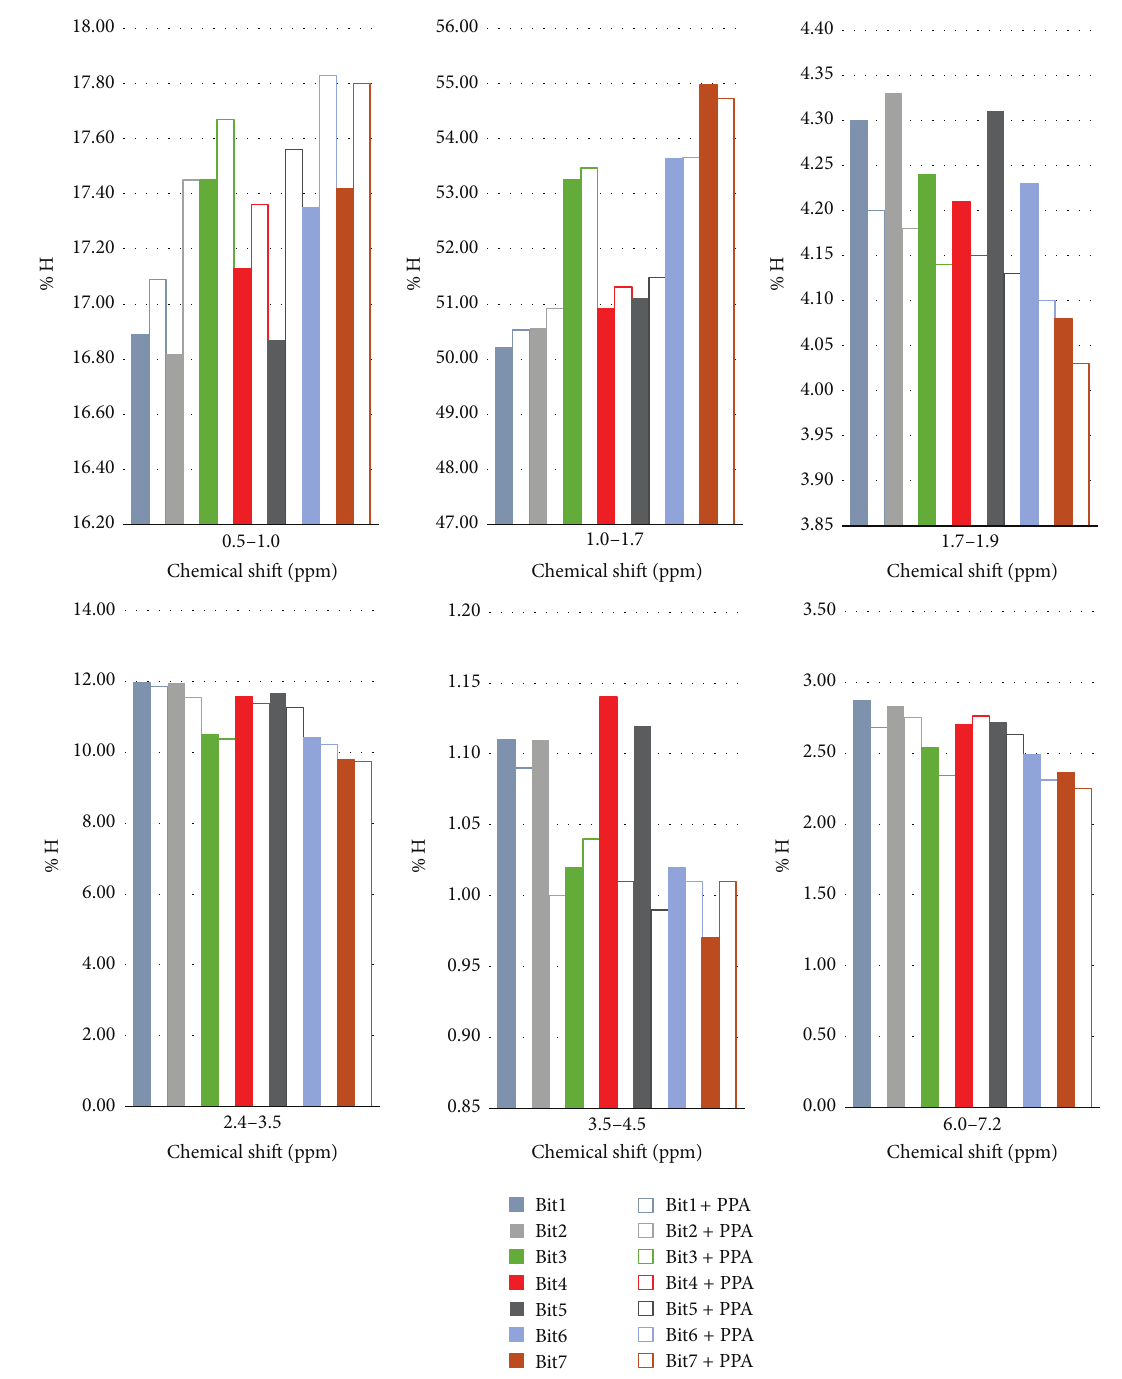
Figure4:Mostsignificantresultsfromthe 1 HNMRspectraofbitumenblendsbeforeandafterPPAaddition.Thetypesofhydrogenassociated with the chemical shift regions are listed in Table